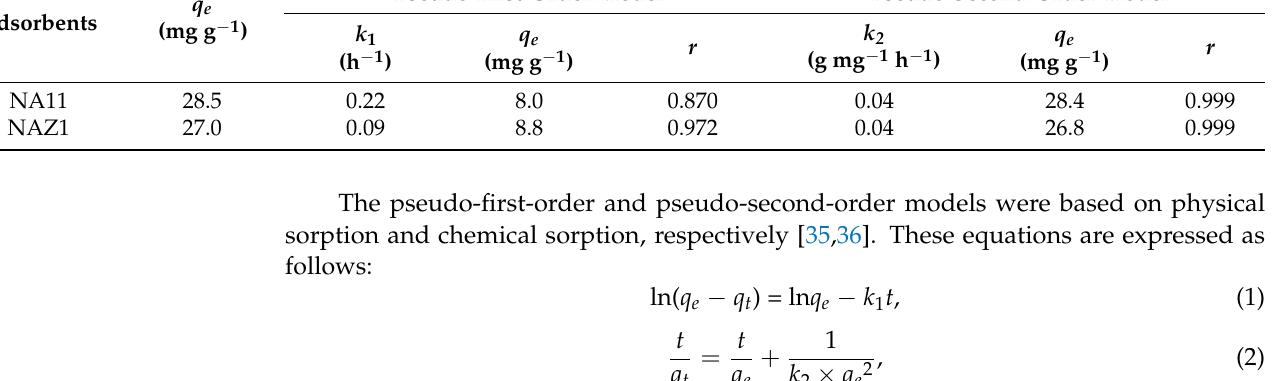
Figure 2. Effect of contact time on the adsorption of Cr(VI) using NA11 and NAZ1.